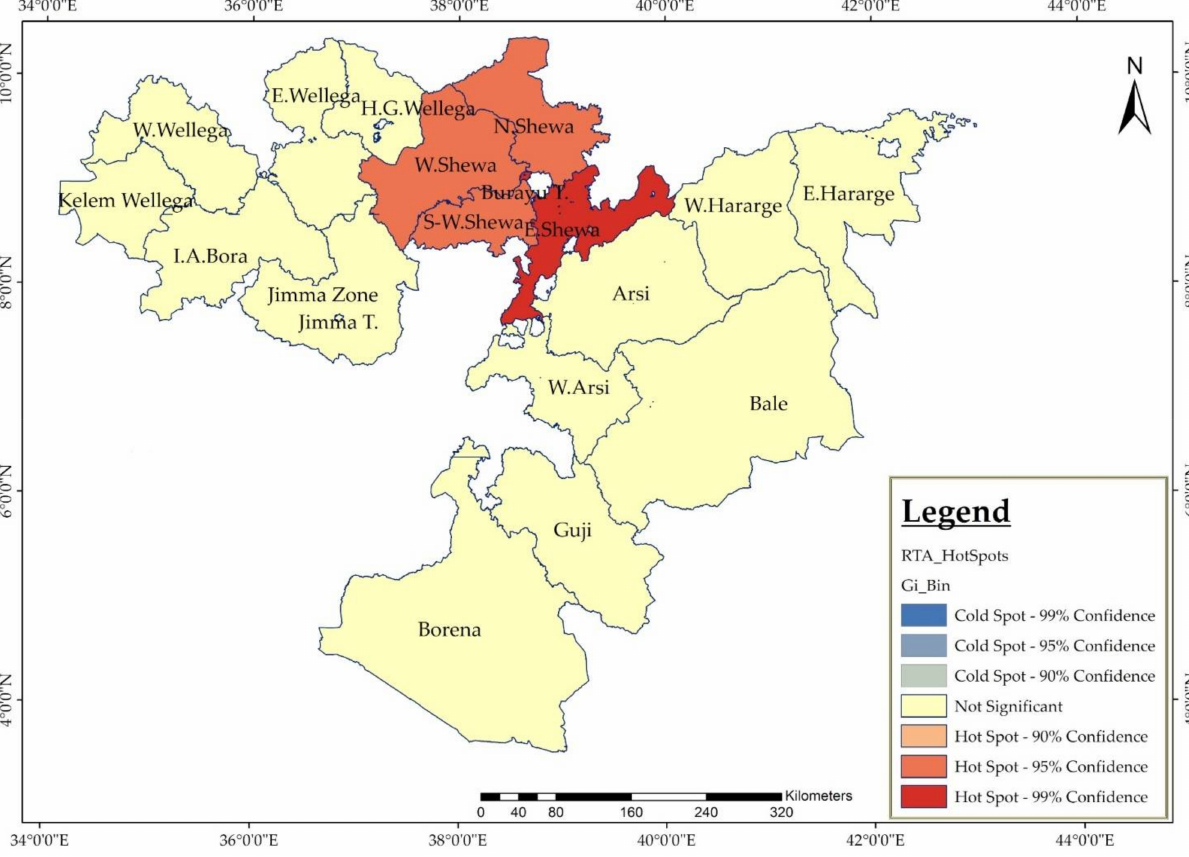
Figure 9. Crash hot spot map of Getis Ord Gi* statistics of Oromia